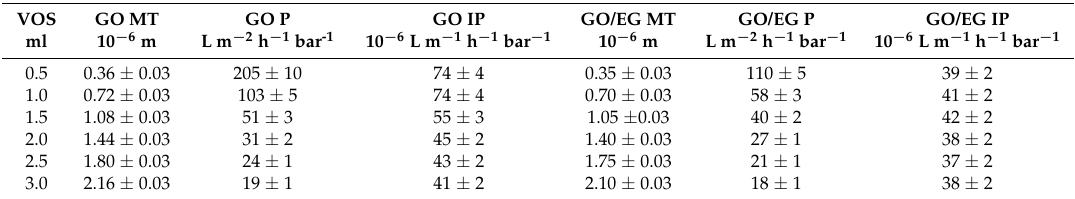
Table 1. The permeability of GO and GO/EG membranes.